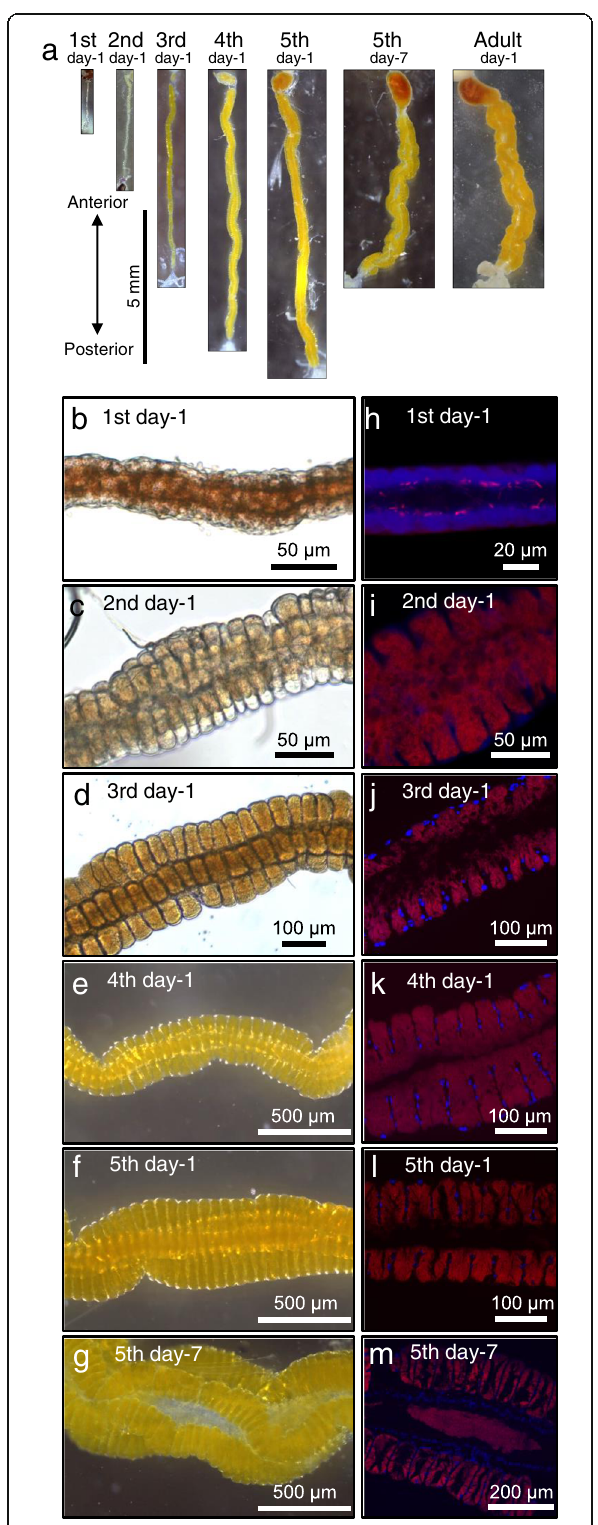
Fig. 4 Development of the symbiotic organ and colonization process of the symbiotic bacteria in P. stali . a Dissected symbiotic organs at different developmental stages: 1st day-1, first instar nymph 1 day after hatching; 2nd day-1, second instar nymph 1 day after molting; 3rd day-1, third instar nymph 1 day after molting; 4th day-1, fourth instar nymph 1 day after molting; 5th day-1, fifth instar nymph 1 day after molting; 5th day-7, fifth instar nymph 7 days after molting; Adult day-1, adult insect 1 day after eclosion. b-g Enlarged bright-field images of the symbiotic midgut. Note that the crypts are obscure at the first instar and become evident at later stages. h – l FISH visualization of the symbiotic bacteria on longitudinal tissue sections of the midgut symbiotic organ. Note that the crypts are obscure and the symbiotic bacteria are sparse at the first instar, whereas the crypts are evidently formed and densely populated by the symbiotic bacteria at later stages. b, h First instar nymphs 1 day after hatching. c , i Second instar nymphs 1 day after molting. d , j Third instar nymphs 1 day after molting. e , k Fourth instar nymphs 1 day after molting. f , l Fifth instar nymphs 1 day after molting. g Fifth instar nymphs 7 days after molting. m Fifth instar nymph 7 days after molting. In h – m , blue and red signals indicate host ’ s nuclear DNA and symbiotic bacteria,